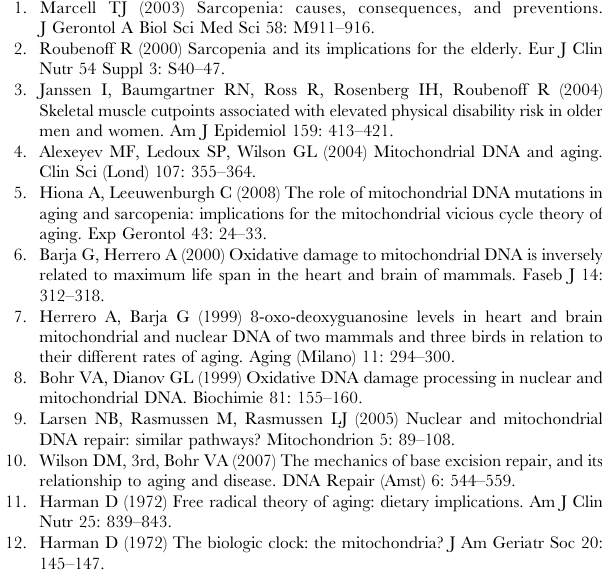
experiment check list. Supplemental description of gene